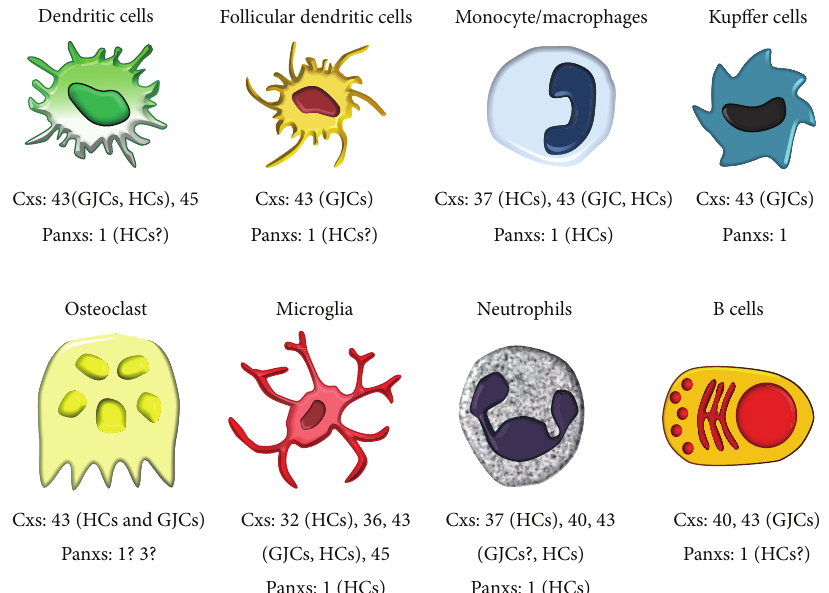
Figure 2: Connexin and pannexin expression in antigen-presenting cells. Summary scheme shows the expression of gap junction channels (GJCs) and hemichannels (HCs) formed by connexins (Cxs) and pannexins (Panxs) in different antigen-presenting cells (APCs). Question marks next to a protein (Cx or Panx) or channel type (GJC or HC) indicate that the expression or function remains unknown or is not fully